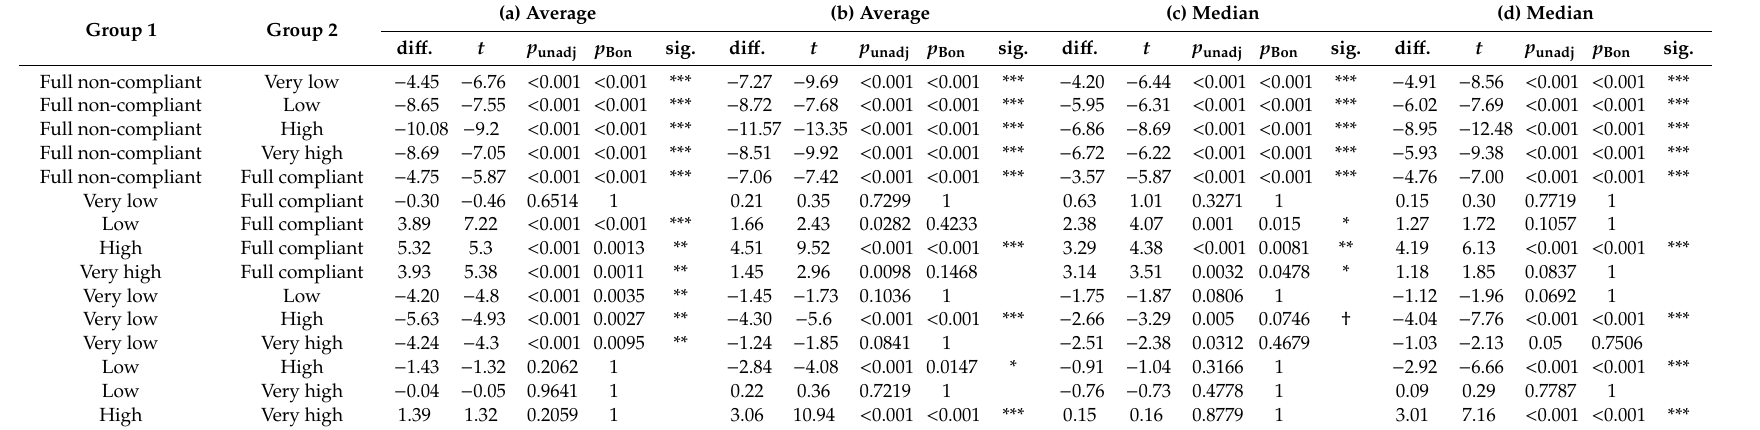
Table 2. Two-sample paired t -test of declaration time by tax compliance level, for Figure